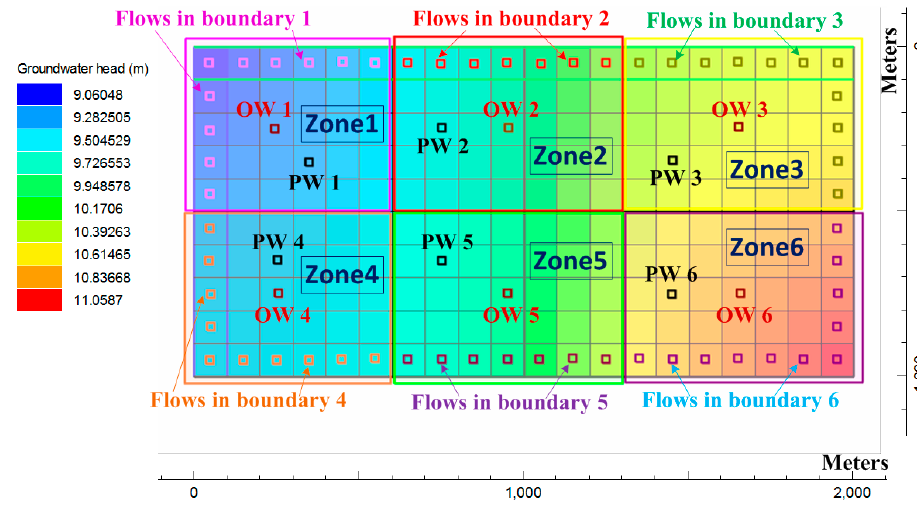
Figure 2. Overview of the numerical experiment area.